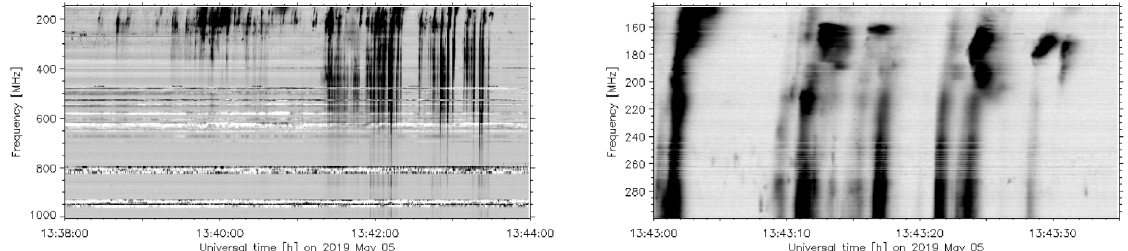
Fig. 6. Dynamic spectra of a group of type III bursts on 2019 May 05, showing the entire group (left panel) and individual bursts (right panel) with 0.1 s